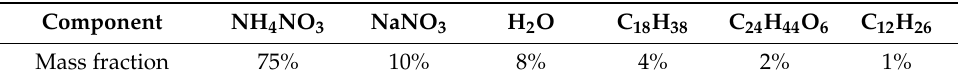
Table 1. Components of the emulsion